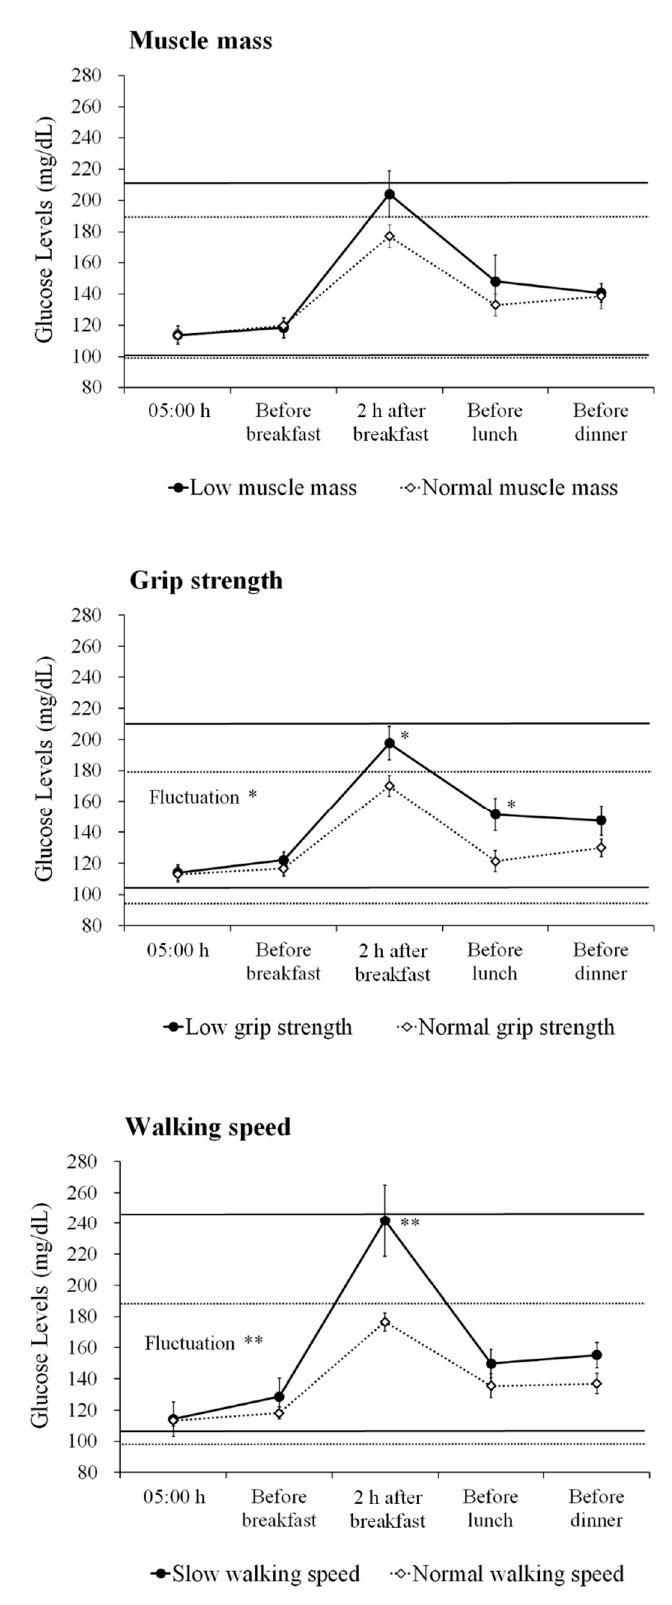
Figure A2. Daily glucose profiles based on the sarcopenia components in the cognitive impairment group. The figures show the average ± SE glucose level based on the components of sarcopenia. ** p < 0.01, * p < 0.05.